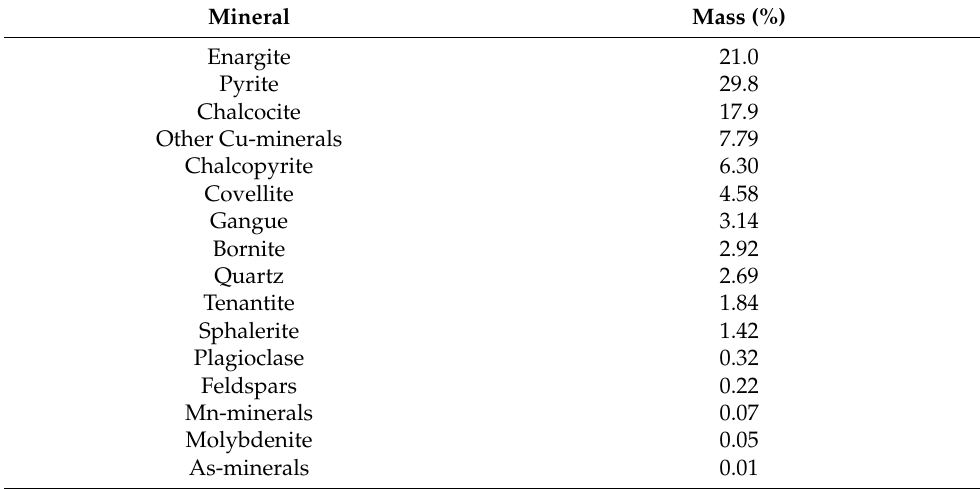
Table 2. Mineralogical composition of copper concentrate determined by Qemscan